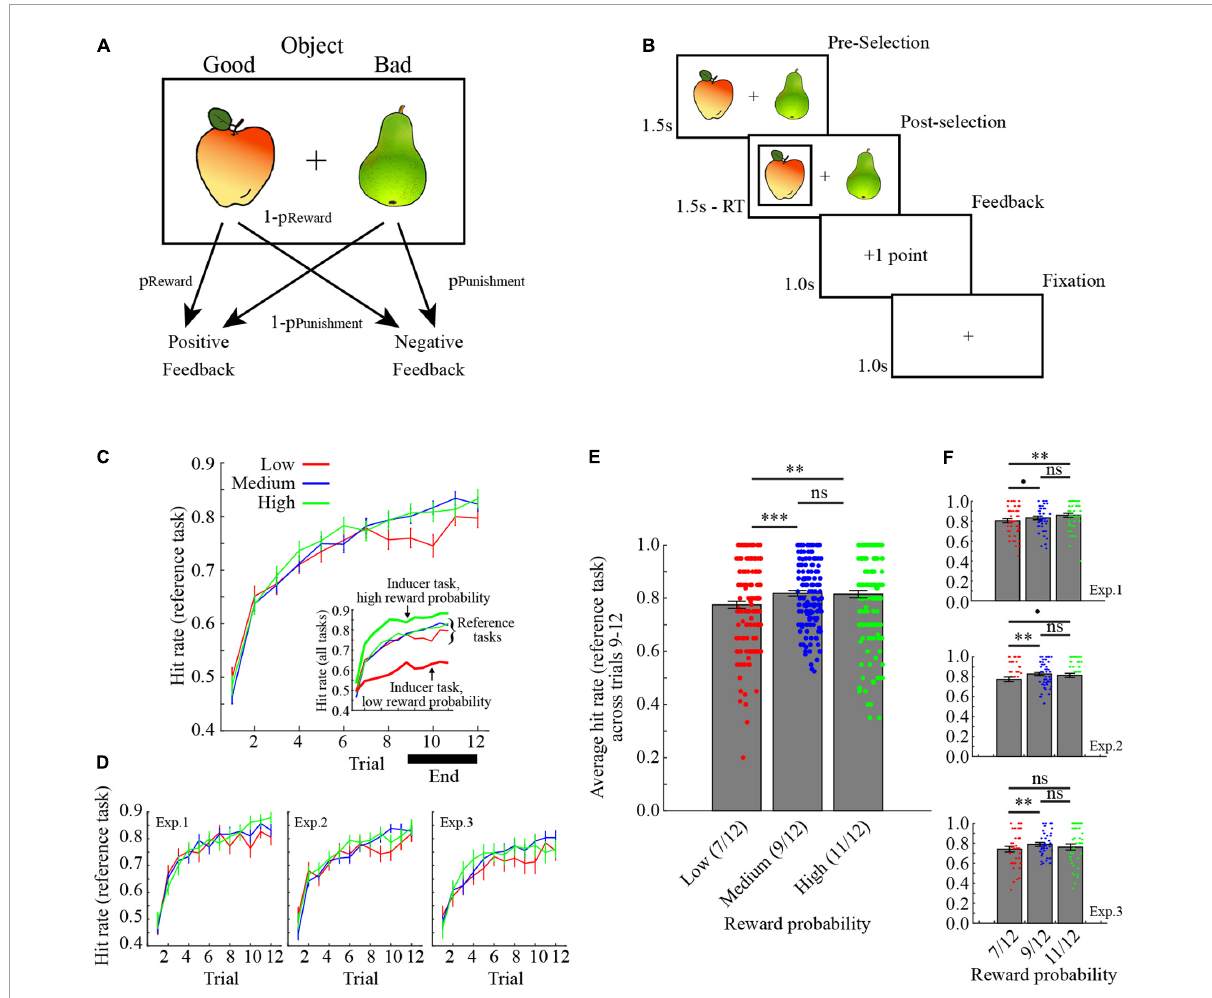
FIGURE1 Task description and learning performance. (A) In each trial, participants selected one of two options in a pair. One object provided positive feedback with probability p Reward , while the other object provided negative feedback with probability p Punishment . Here, p Reward was always equal to p Punishment . (B) Illustration of a trial. (C) Learning curves for the reference tasks, collapsed across the three experiments. The inset also shows performance for the inducer tasks with low- and high reward probabilities. Inducer/reference tasks are, respectively denoted by bold / narrow lines. (D) Learning curves for the reference task in the three experiments separately. (E) Average learning performance for the reference tasks across trials 9–12 collapsed across the three experiments. (F) Average learning performance for the reference tasks across trials 9–12 separately for the three experiments. ∗∗∗ p < 0.001, ∗∗ p < 0.01, ∗ p < 0.05, p < 0.10, ns p > 0.10. All error bars indicate the standard error of the